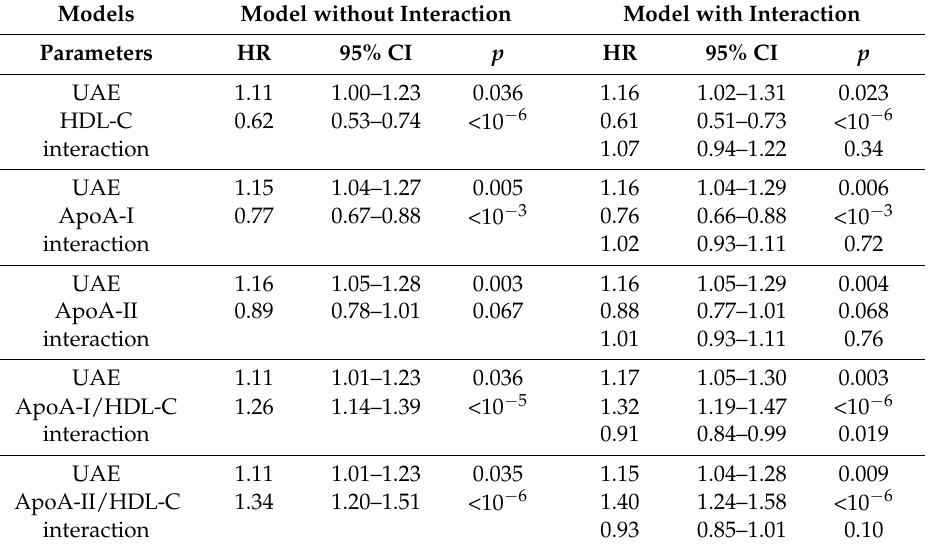
Table 2. Interaction of urinary albumin excretion (UAE) with HDL-related parameters for baseline evaluation data as assessed by Cox proportional hazards models of cardiovascular event occurrence adjusted for gender and age. Hazard ratios are per SD unit for all variables.